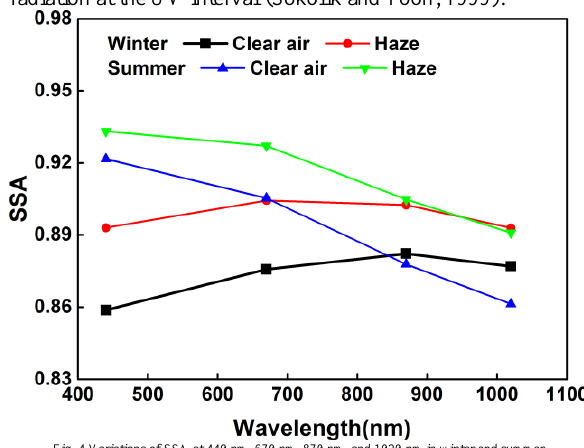
Fig. 4 Variations of SSA at 440 nm, 670 nm, 870 nm, and 1020 nm in winter and summer.